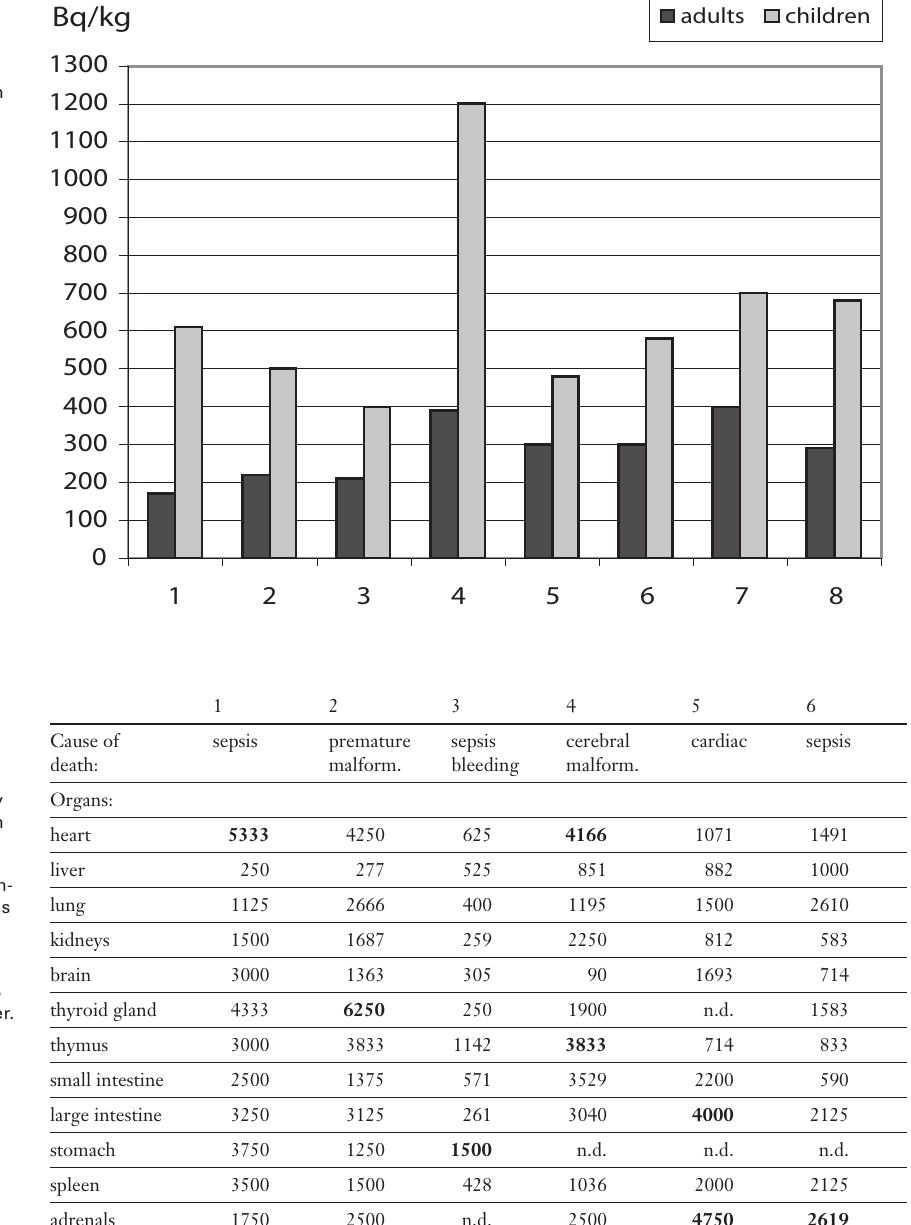
Radioisotopes accumulation in the organs of adults and children, died